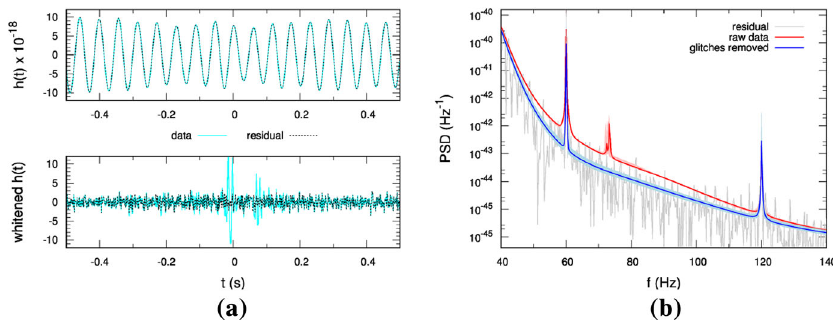
Fig.75 Panel a showsa1-secondsampleofLIGOS6data.The upperplot showstherawdataandthe lower plot shows the data whitened by the median BayesLine spectra with glitch subtraction by the BayesWave algorithm. The solid aqua line is the data before glitch removal, and the dotted black line is after glitch removal. Panel b shows the median and 90% credible bands for the spectral model with ( blue ) and without ( red ) glitch subtraction. The grey line shows the power spectra of the data after glitch removal. Images provided by Tyson